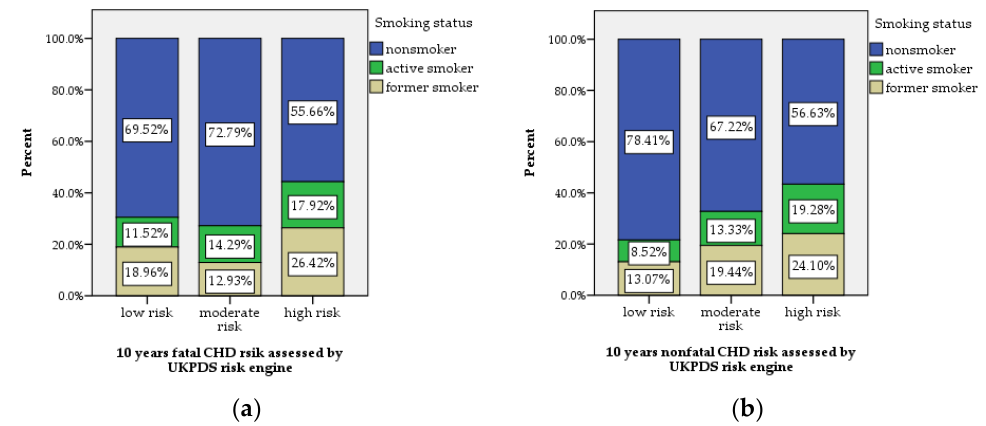
Figure 4. The distribution of smoking status in the study population ( a ) patients with T2DM and high risk of fatal CHD were in a statistically significant higher percentage for active and former smokers ( p = 0.023) and ( b ) active and former smokers were statistically more frequent within the patients with T2DM and moderate and high risk of nonfatal CHD ( p = 0.001).